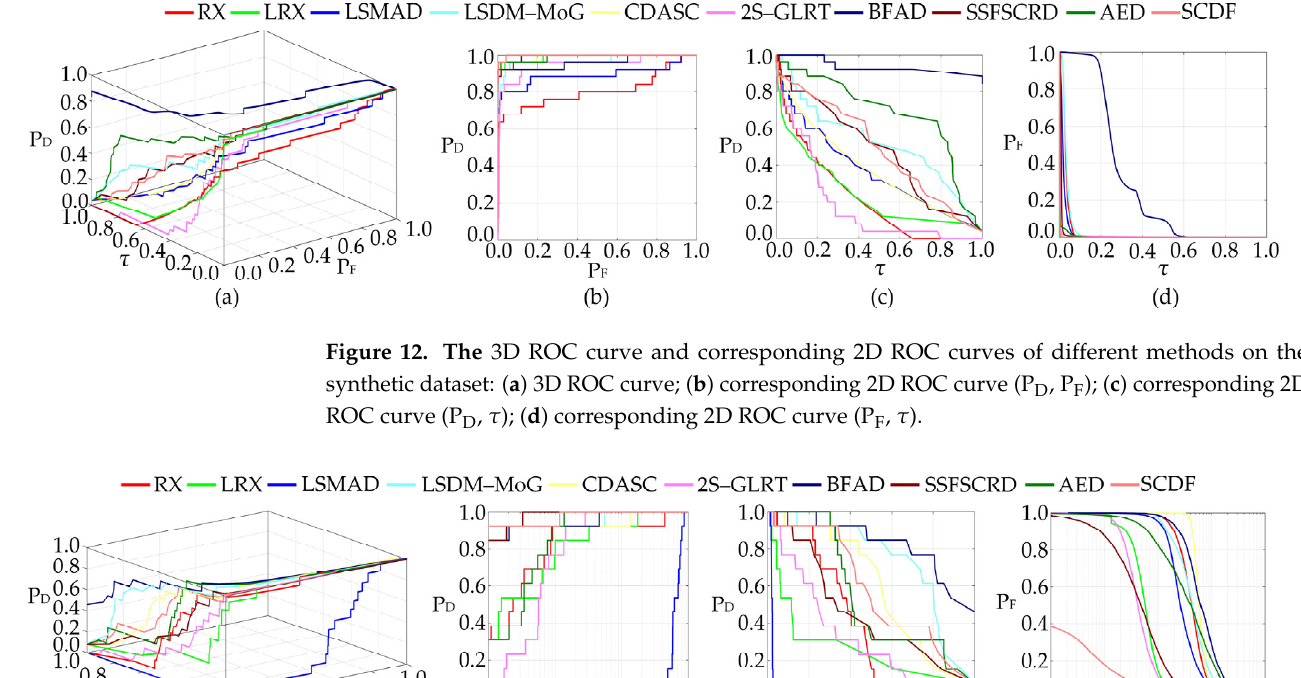
Table 3. Comparison of AUC performance of different methods on the urban dataset.